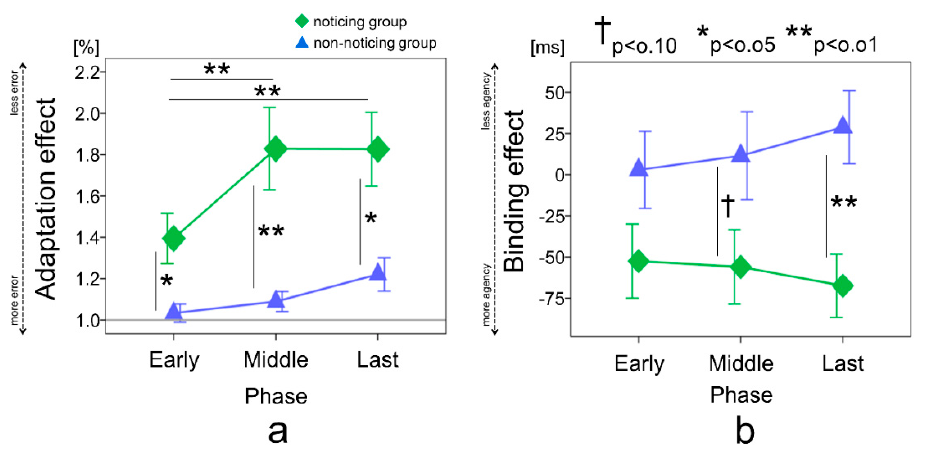
Figure 2. ( a ) Adaptation effect for each group in each phase. 1.0 indicates the baseline. ( b ) Binding effect for each group in each phase. The data represent the means ± standard error; † indicates a p -value < 0.1; * indicates a p -value < 0.05; ** indicates a p -value < 0.01; green square plot = noticing group; blue triangle plot = non-noticing group.